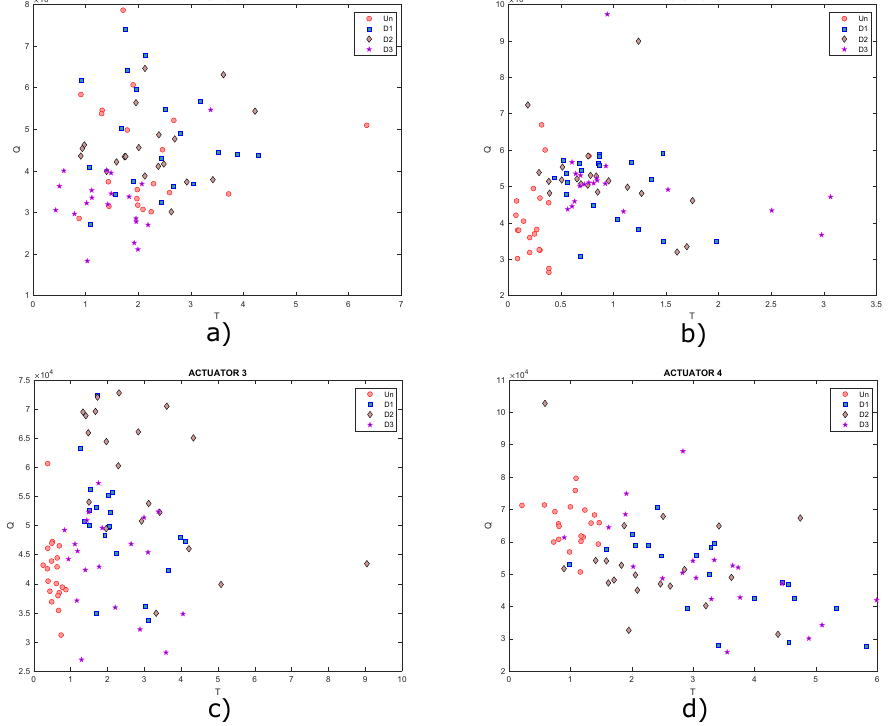
Figure 21. Graphs of T 2 vs. Q for actuation phases: ( a ) 1; ( b ) 2; ( c ) 3 and ( d )